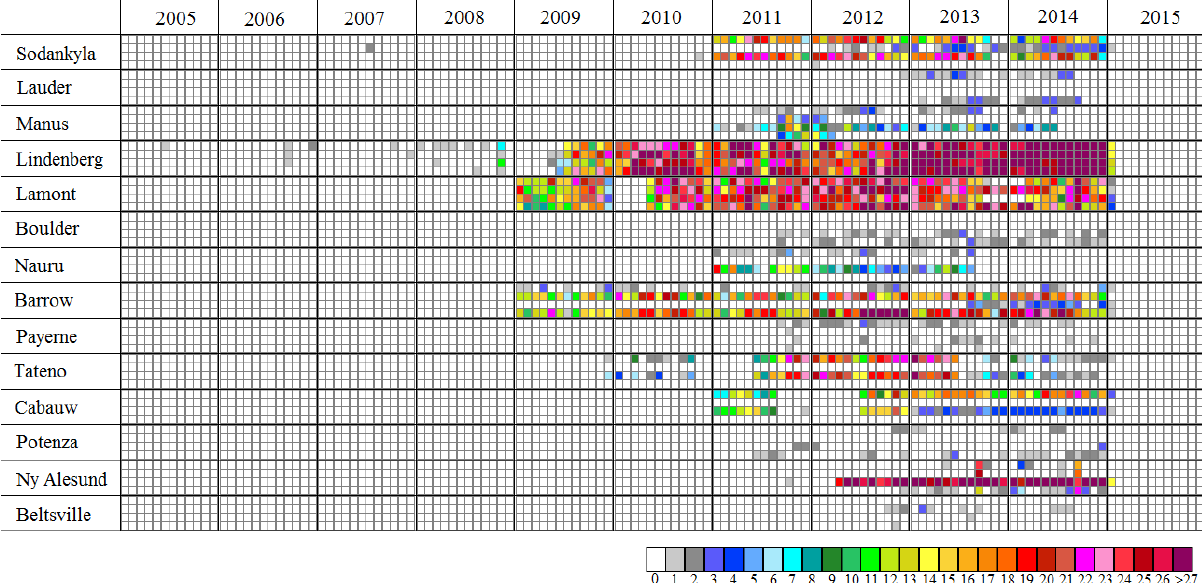
Figure 5. The availability of RS92 radiosonde data at a sub-set of the GRUAN sites (not all GRUAN sites currently provide RS92 radiosonde measurements) at the time of the writing of this paper. Each site shows data in four rows indicative of the four 6h periods through the day. Vertical columns in the grid indicate individual months with the years are listed across the top. The number of RS92 radiosonde flights available in each month in each 6h period is shown using the colour scale in the bottom right corner of the